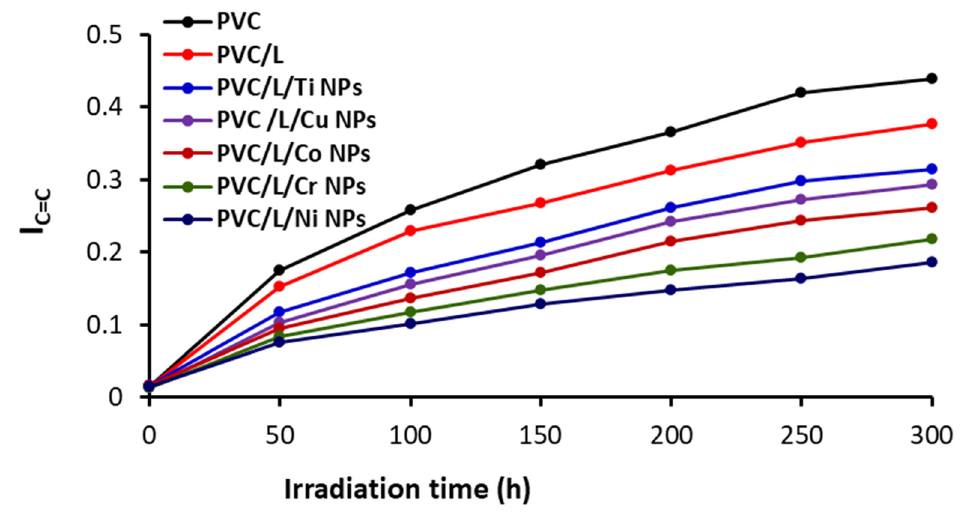
Figure 4. The I C=C index as a function of irradiation time for PVC fi lms.